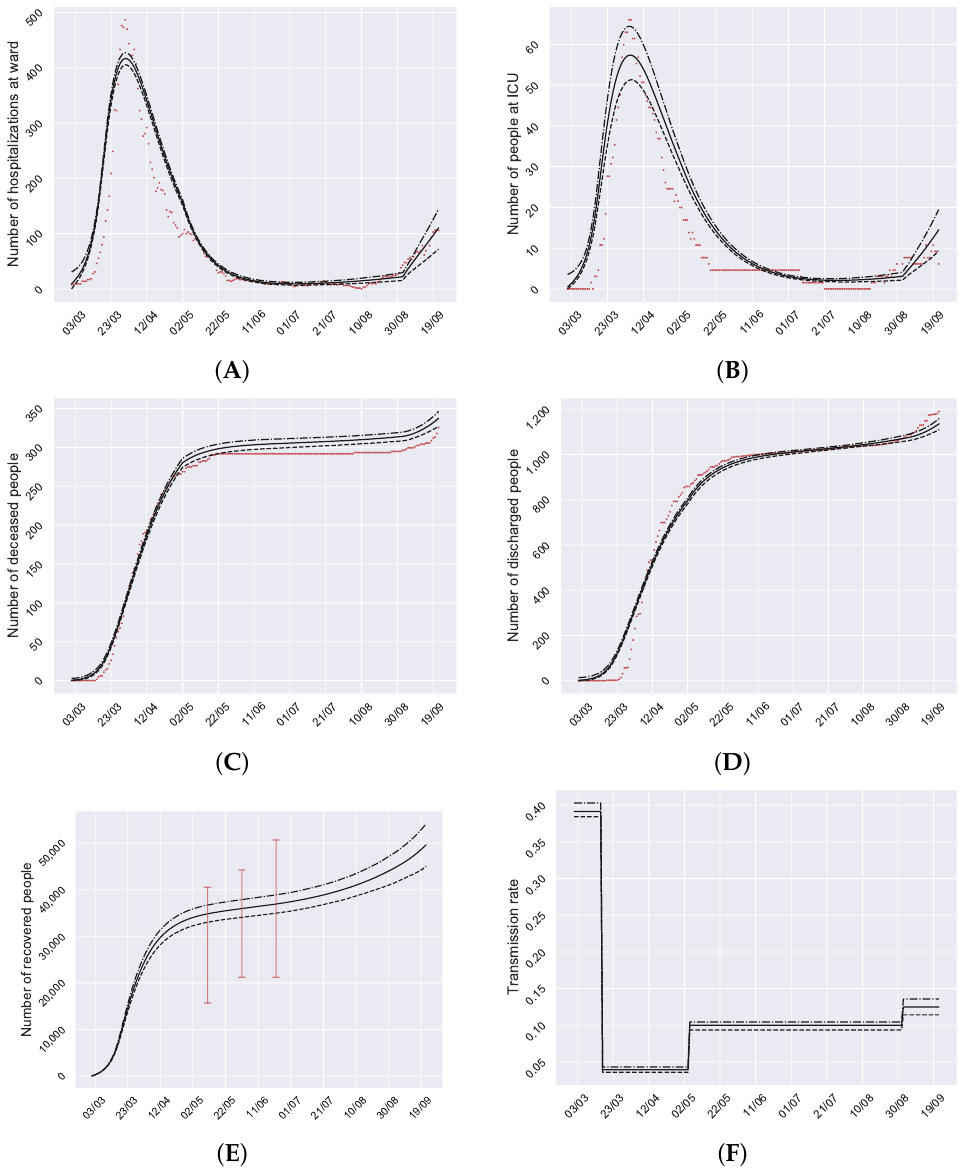
Figure 2. Model calibration. ( A ) Number of daily hospitalized at ward people. ( B ) Number of daily people in ICU. ( C ) Number of accumulated deceased people. ( D ) Number of accumulated discharged people. ( E ) Number of accumulated recovered people. ( F ) Transmission rate β . The black bands are the mean and the CI95%. The red points are the data from the hospitals. Vertical red lines in ( E ) show the confidence intervals of the prevalence in Granada given by